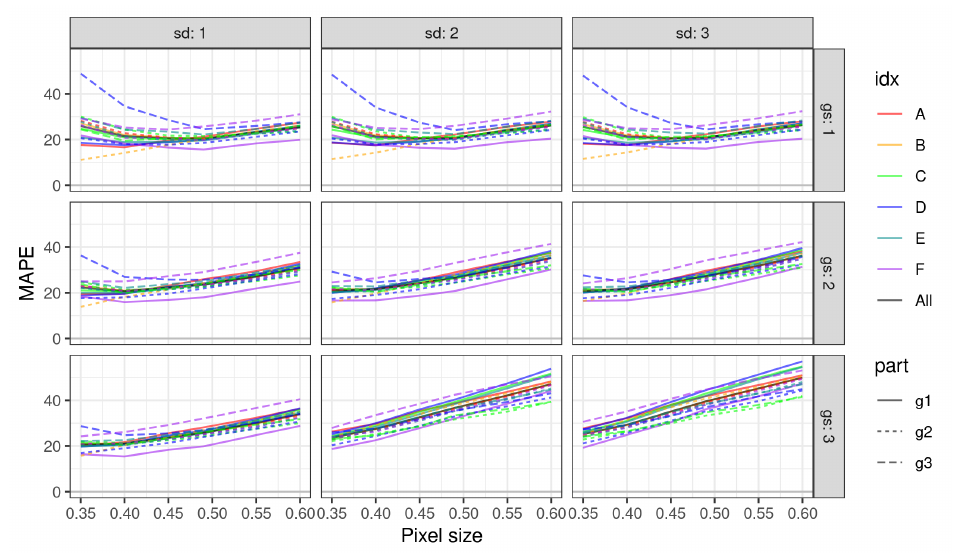
Figure 16. Variability of the MAPE metric as a function of Watershed method parameters—Canopy Height Model (CHM) spatial resolution (pixel size in meters), Gaussian smoothing strength (Gaussian filter window size (gs) and standard deviation (sd) in pixels)—and with respect to groupings of circular plots in different categories (A–F, g1–g3, see Table 2; the ’All’ group represents the entire set of sample